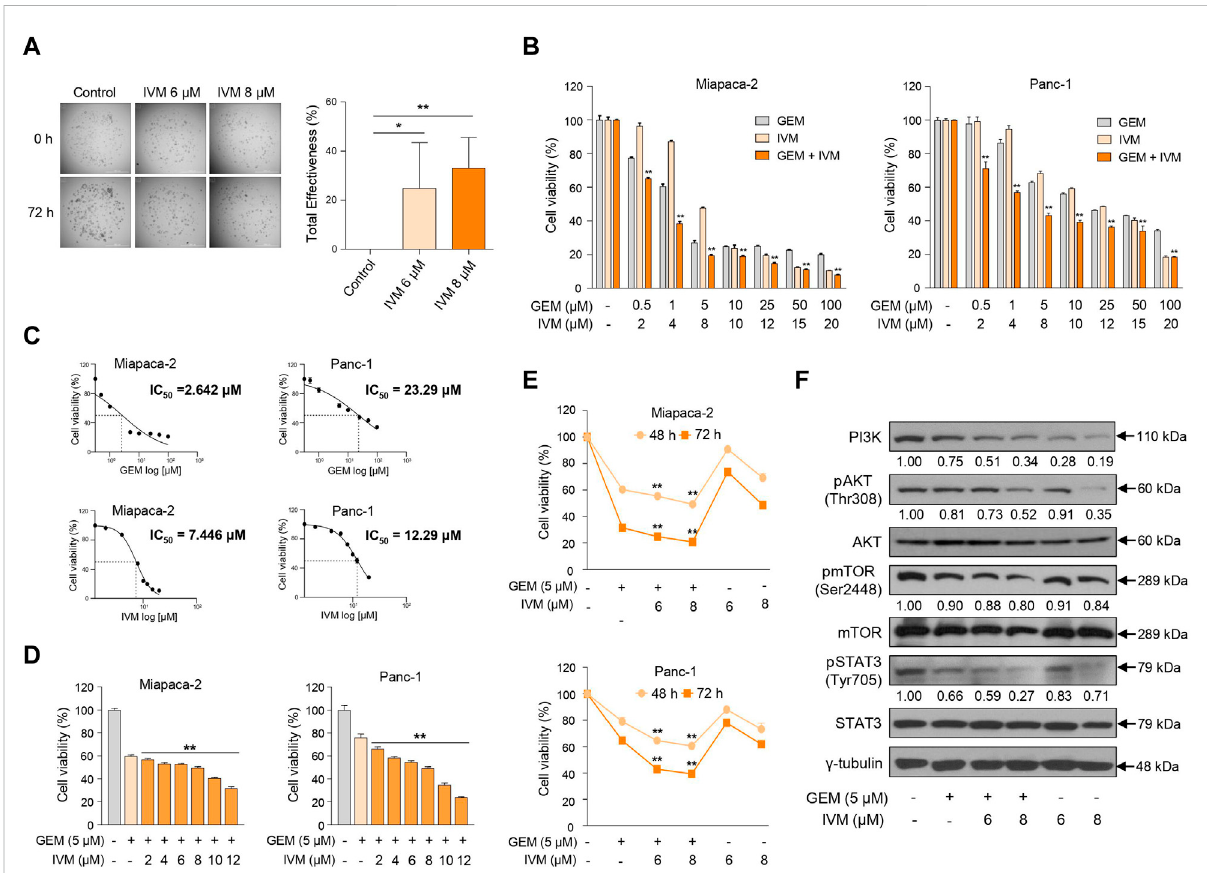
FIGURE 1 Ivermectin inhibits the proliferation of pancreas cancer cells. (A) Morphological changes in patient-derived organoids were monitored for 72 h aftertreatmentwithivermectinat6and8 μ Mconcentrations.Totalinhibitingeffectivenessofivermectinwascalculated.Datarepresentsthemean± standard deviation (SD) (n = 5). * p < 0.05; ** p < 0.01 compared with the control group. Scale bar = 1000 μ m. (B) MIA PaCa-2 and PANC-1 cells were seeded in a 96-well plate and treated with increasing doses of gemcitabine and ivermectin for 72 h. Cell viability was determined using the water-soluble tetrazolium (WST) assay. (C) Median inhibitory concentration (IC 50 ) values of gemcitabine and ivermectin for each cell line are shown. (D) MIA PaCa-2 and PANC-1 cells were treated with 5 μ M gemcitabine and increasing doses of ivermectin for 48 h (E) MIA PaCa-2 and PANC-1 cells were treated with the indicated concentrations of gemcitabine and ivermectin for 48 and 72 h (F) MIA PaCa-2 cells were treated with gemcitabine and ivermectin at the indicated concentrations, and the protein expression levels were determined using western blotting. (B,D,E) Data represents the mean ± SD ( n = 3). * p < 0.05 and ** p < 0.01 compared with the gemcitabine alone